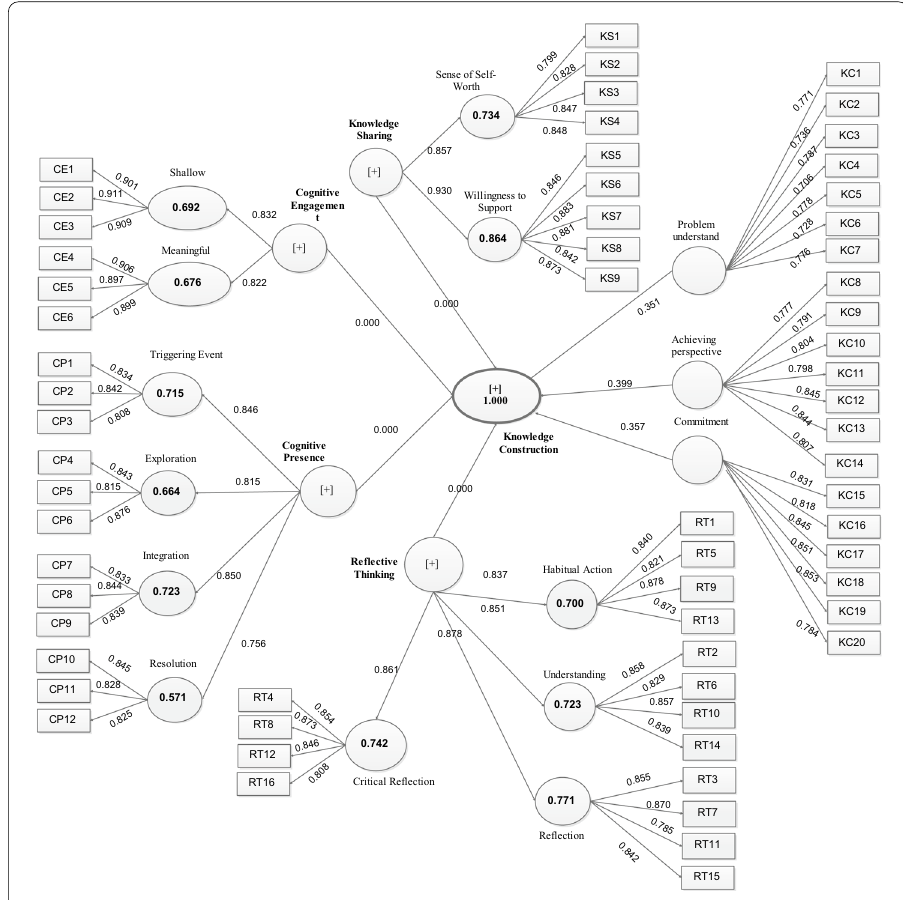
Fig. 3 The research